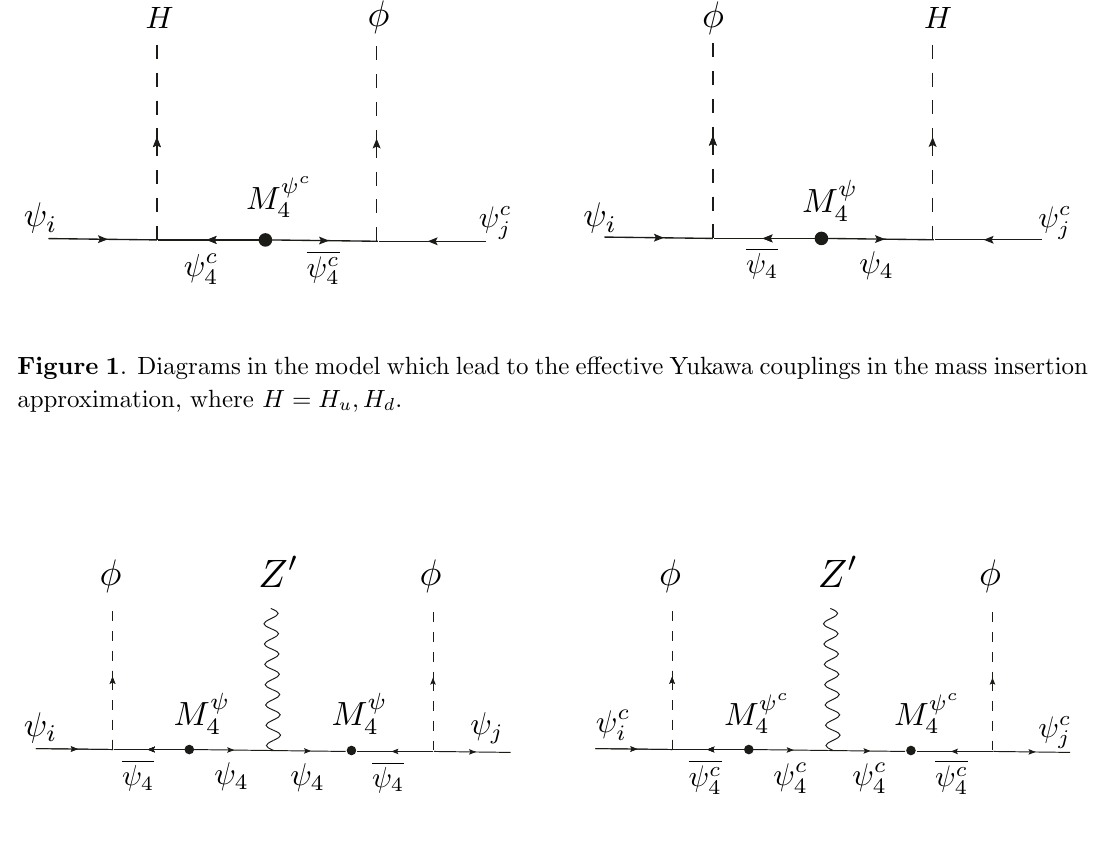
couplings in the mass insertion 0